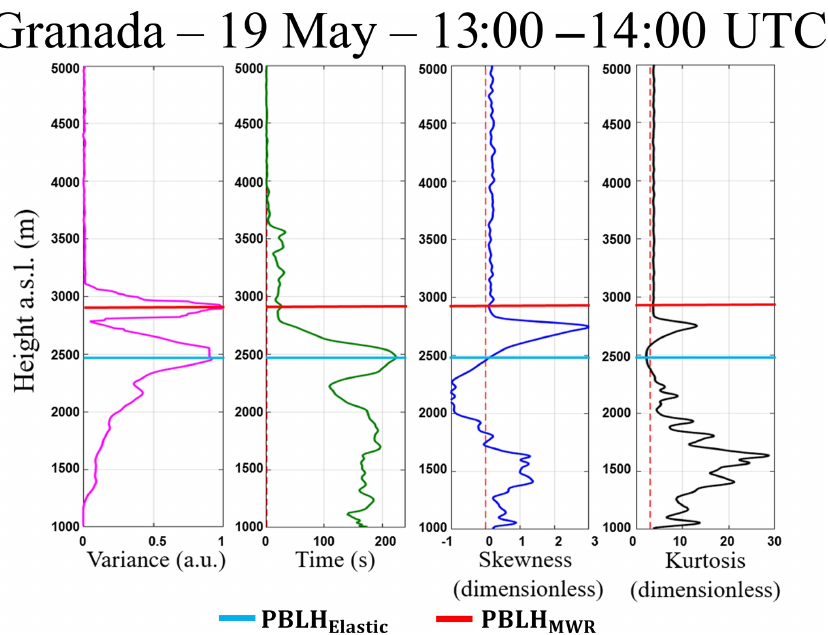
Figure 13. Statistical moments obtained from 1064nm wavelength data of elastic lidar (MULHACÉN) in Granada from 13:00–14:00UTC on 19 May 2016. From left to right is the variance ( σ 2 ), integral timescale ( τ RCS (cid:48) ), skewness ( S RCS (cid:48) ) and kurtosis ( K RCS (cid:48) ). RCS (cid:48)